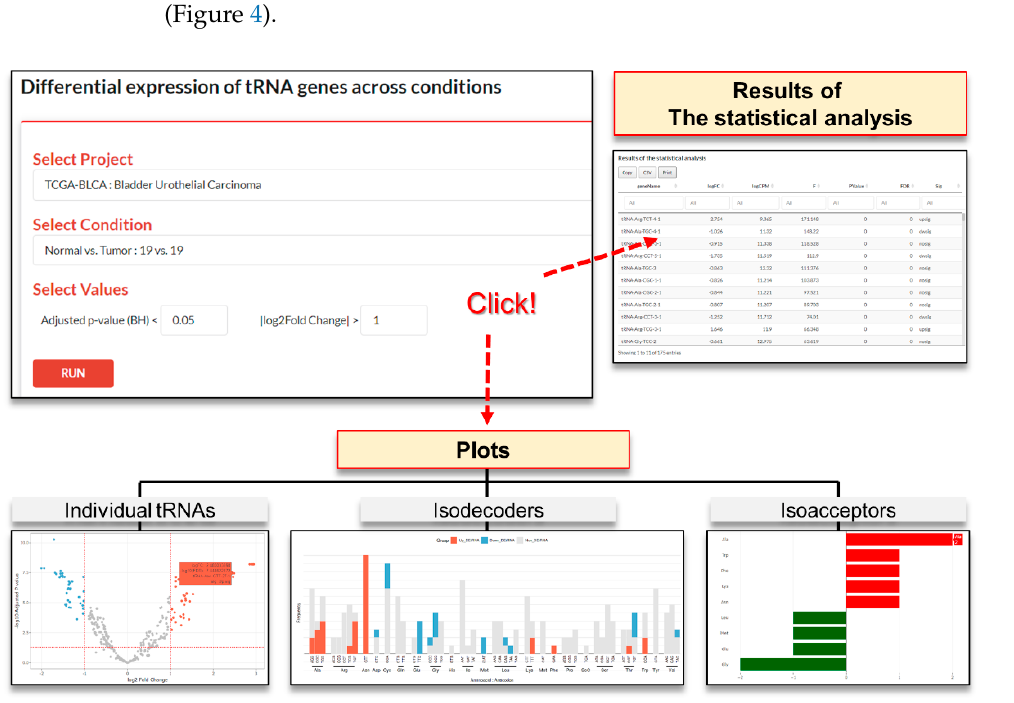
Figure 4. The ‘Explore DEtRNAs’ page.